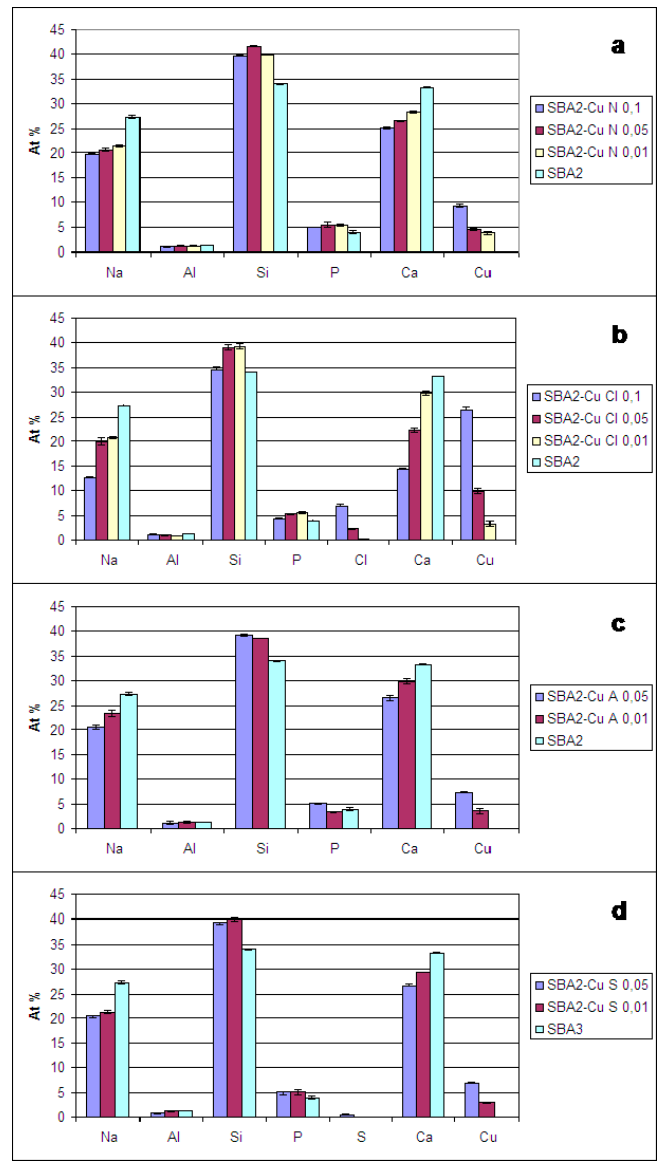
Figure 3. Energy Dispersion Spectrometry (EDS) analyses of SBA2 powders before ion-exchange after in ( a ) copper(II) nitrate (SBA2-Cu N); ( b ) copper(II) chloride (SBA2-Cu Cl); ( c ) copper(II) acetate (SBA2-Cu A); and ( d ) copper(II) sulphate solutions (SBA2-Cu S). Table 2. Summary of Cu amount and presence of a crystalline phase detected by EDS and XRD analyses, respectively, for all ion-exchanged